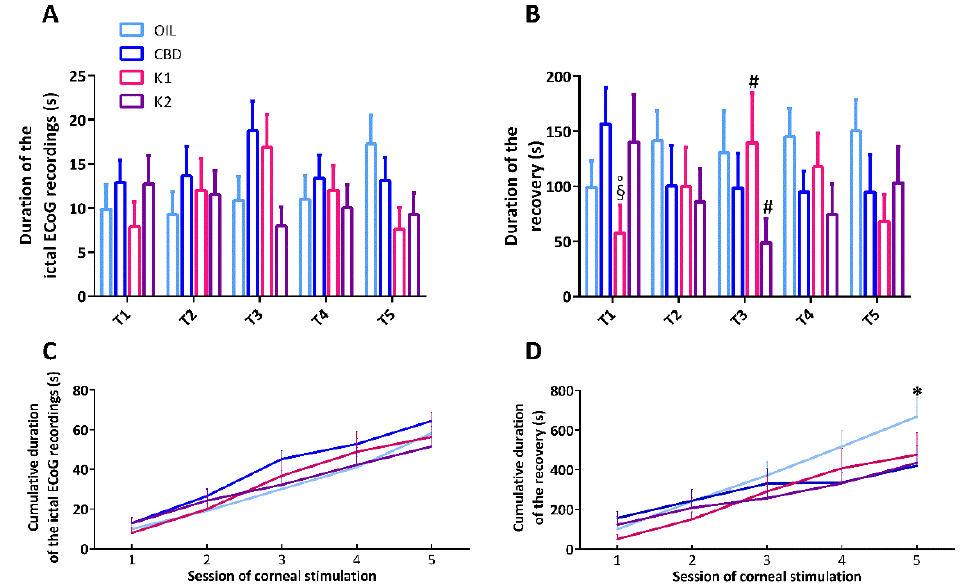
Figure 5. Duration of ictal electrocorticographic (ECoG) recordings, time to recover from seizures, and the cumulative effect of the treatments. All mice ( n = 32) were treated with CBD ( n = 8), K1 ( n = 8), K2 ( n = 8), or olive oil ( n = 8). In ( A ), no treatment had beneficial effects on the total duration of seizures after the 6-Hz corneal stimulations. In ( B ), K1 and K2 had occasional beneficial effects on time to recover from seizures. In ( C ), no treatment had beneficial effects on the cumulative duration of the ictal ECoG recordings, but this cumulative duration significantly increased from the first to last session of stimulation in all groups. In ( D ), the cumulative duration of recovery significantly increased from the first to last session of stimulation in all groups, but only K2 had a significant cumulative effect on the time to recover from seizures. * p < 0.050 K2 vs. OIL; § p < 0.050 K1 vs. CBD; ° p < 0.050 K1 vs. K2; # p < 0.050 vs. session 1; Duncan’s method. T1–T5, from the first to the fifth session of corneal stimulation; OIL, olive oil; CBD, cannabidiol; K1, hemp oil 1; K2, hemp oil